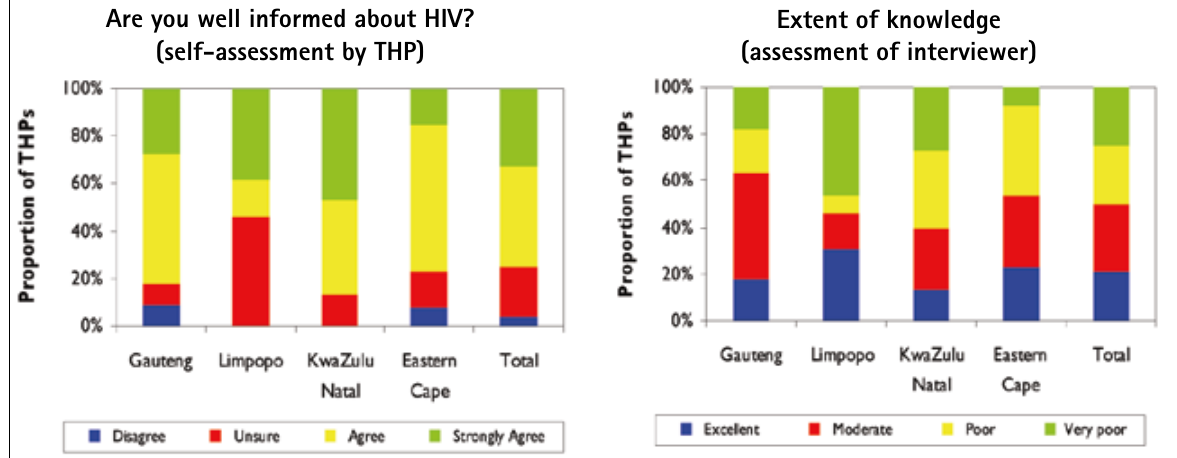
Fig. 1. Extent of knowledge (THPs and interviewer